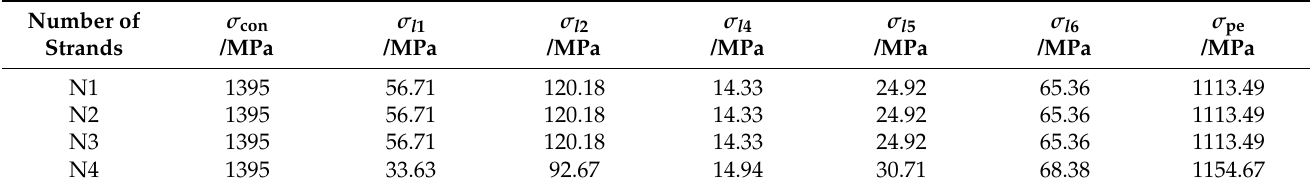
Table 3. Prestress loss.